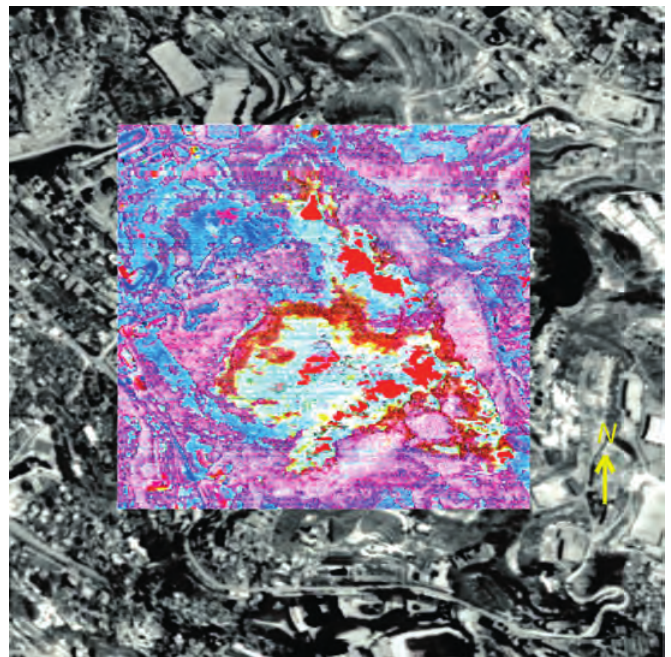
Fig. 6. Spectral emissivity image in DAIS channels 78-76-74 (RGB).